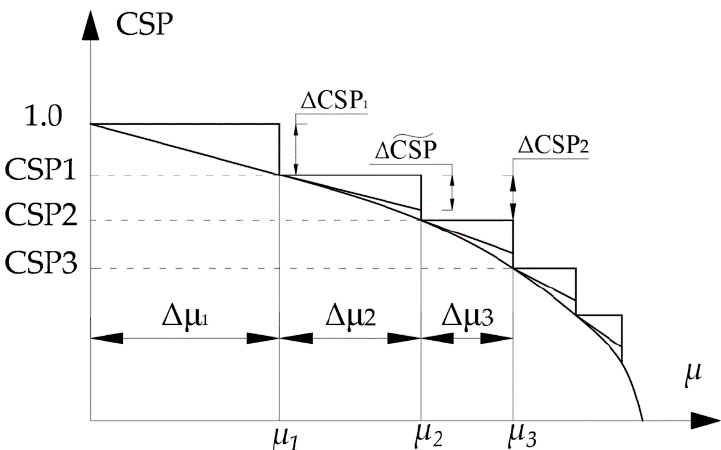
Figure 3. Estimation of effective step